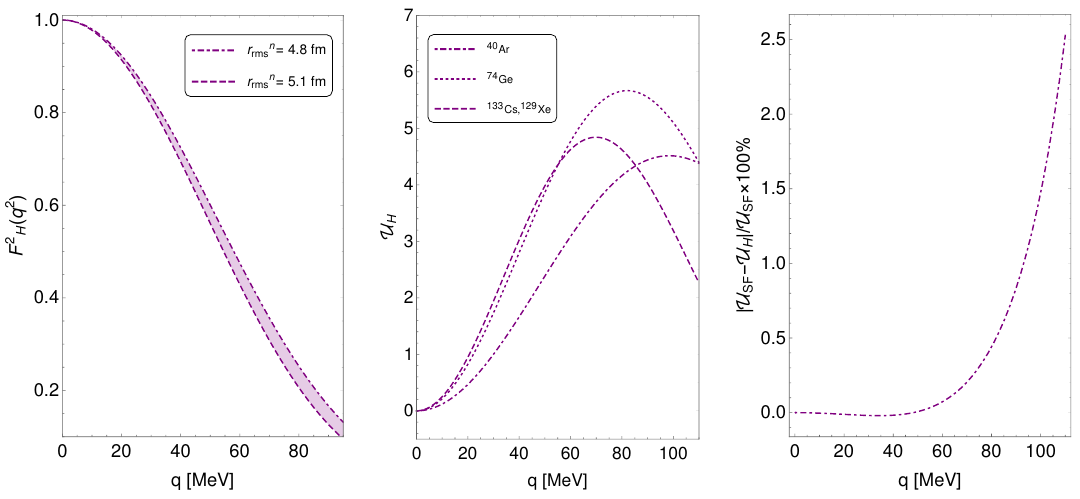
Figure 1 . Left : square of the Helm form factor as a function of the momentum transfer q . p The upper (lower) curve is obtained by (cid:12)xing h r 2 i H to r p ( r p + 0 : 3 fm) as given in table 1 rms rms for 133 Cs. Middle : percentage uncertainty for 133 Cs, 129 Xe, 74 Ge and 40 Ar (for 40 Ar, we take r n j max = r p +0 : 2 fm). It can be seen that uncertainties get larger as q increases to 65 MeV. Right : rms rms relative di(cid:11)erence between the Helm and symmeterized Fermi form factors uncertainties for 133 Cs. Using the Klein-Nystrand form factor yields results of the same order and so are not displayed. The main point is that the size of the uncertainties do not depend on the form factor